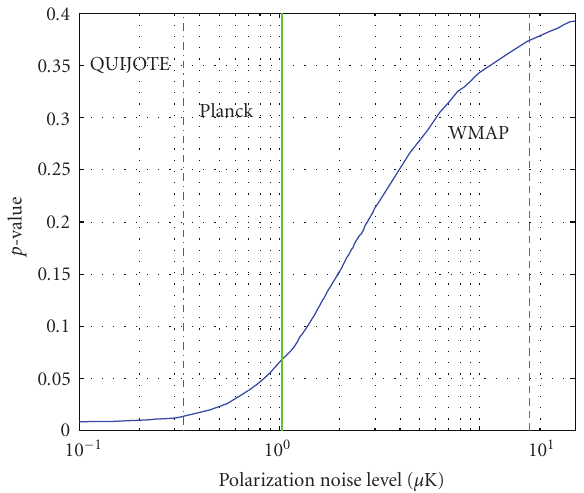
Figure 14: The curve indicates the probability (the p -value) for rejecting the texture hypothesis, attending to the T-E correlation, as a function of the instrumental noise sensitivity in polarization. From left to right, the vertical lines indicate the noise level associated with QUIJOTE, Planck, and WMAP